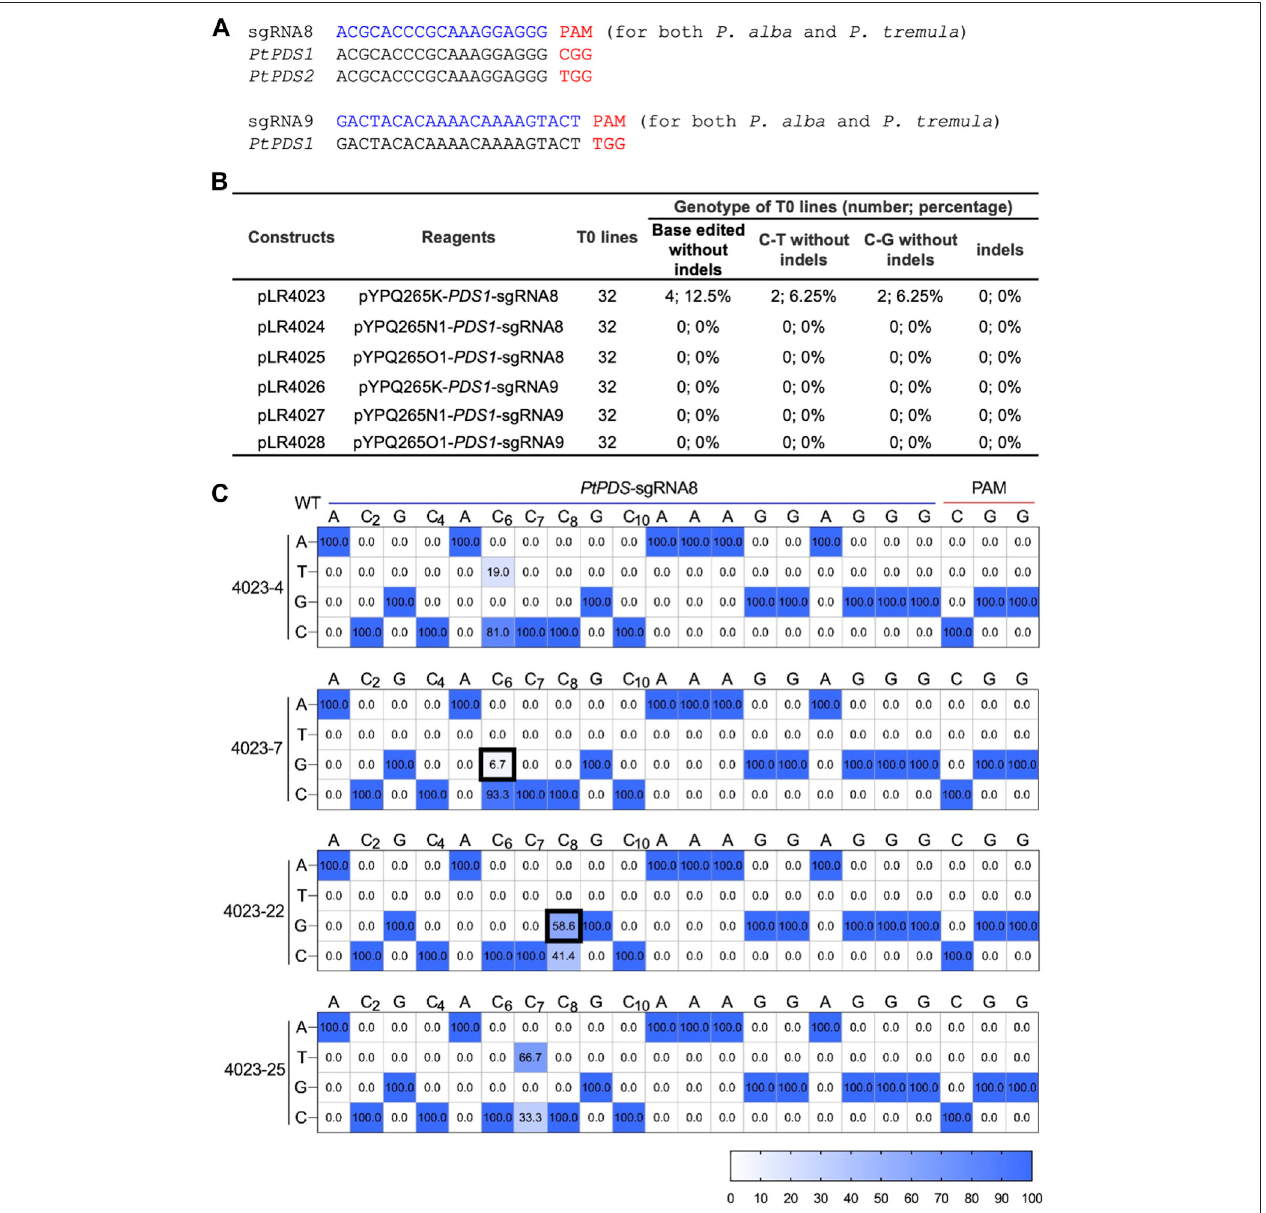
FIGURE 5 | C-to-G base editing in stable poplar lines (A) Target sequences in the poplar hybrid. Note both P. alba and P. tremula genomes are targetable by the sgRNAs due to having identical protospacers. (B) Summary of editing outcomes in transgenic T0 lines (i.e., monoallelic and non-chimeric) by different CGBEs in poplar (C) Base-edited T0 lines (i.e., monoallelic and non-chimeric). at the PtPDS-sgRNA8 site with editing frequencies quanti fi ed by NGS and Hi-Tom analysis.